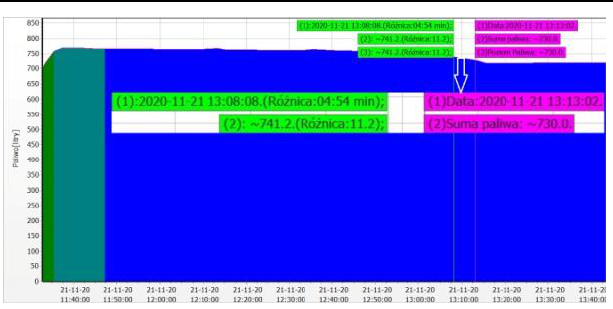
Fig. 8. Measurement of hourly fuel consumption FC [l/h] of a CAT C27 engine (6Dg locomotives) with additive. Test F, point 